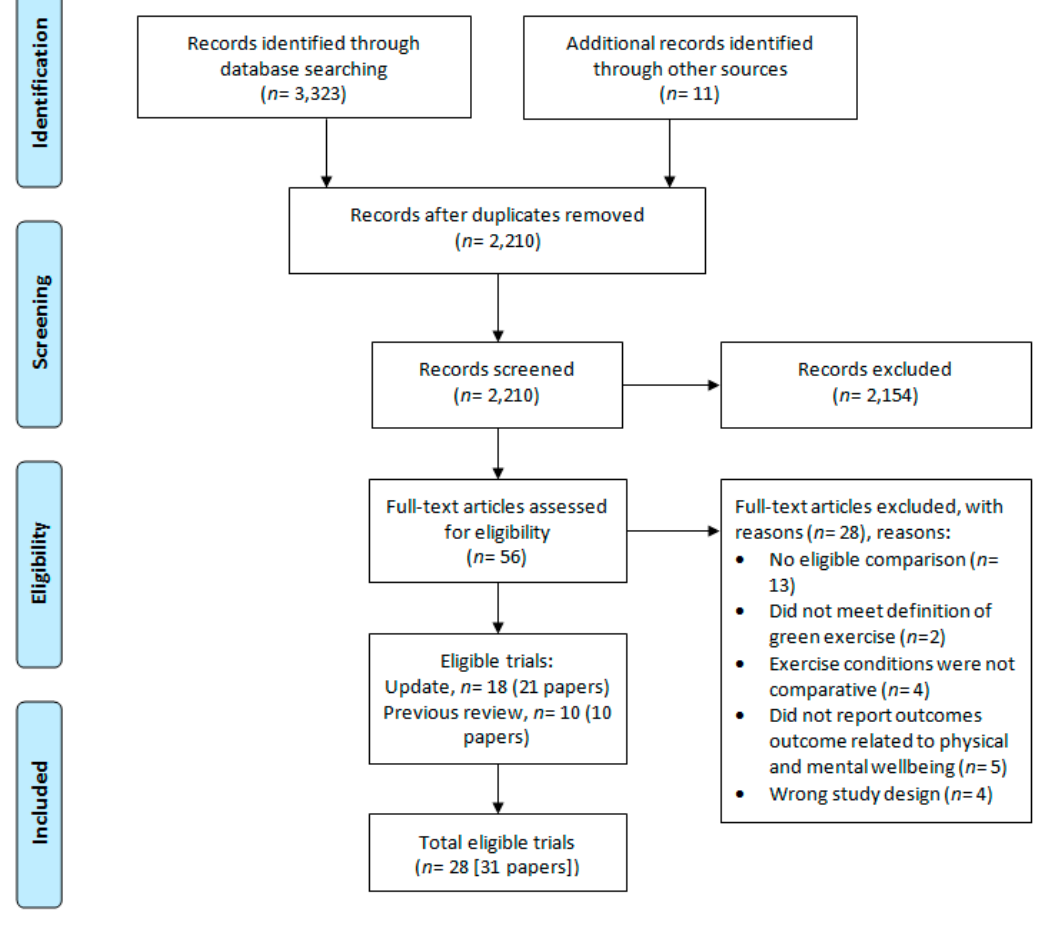
Figure 1. Flow of Figure 1. Flow of studies